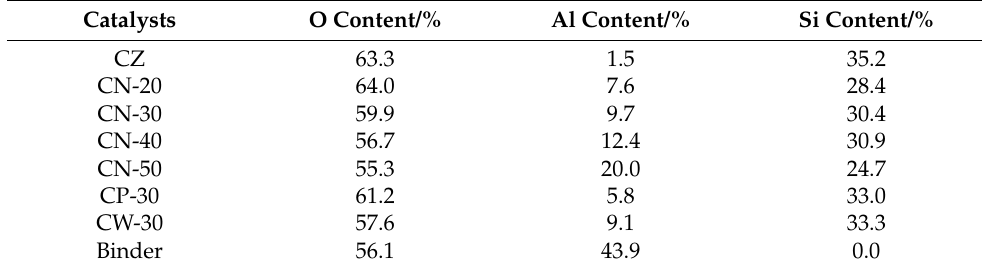
Figure 11. SEM-EDS elemental mapping of the catalysts: ( a ) CZ; ( b ) CN-20; ( c ) CN-30; ( d ) CN-40; ( e ) CN-50; ( f ) CP-30; ( g ) CW-30; and ( h ) binder. Table 3. Element distribution results of the catalysts from